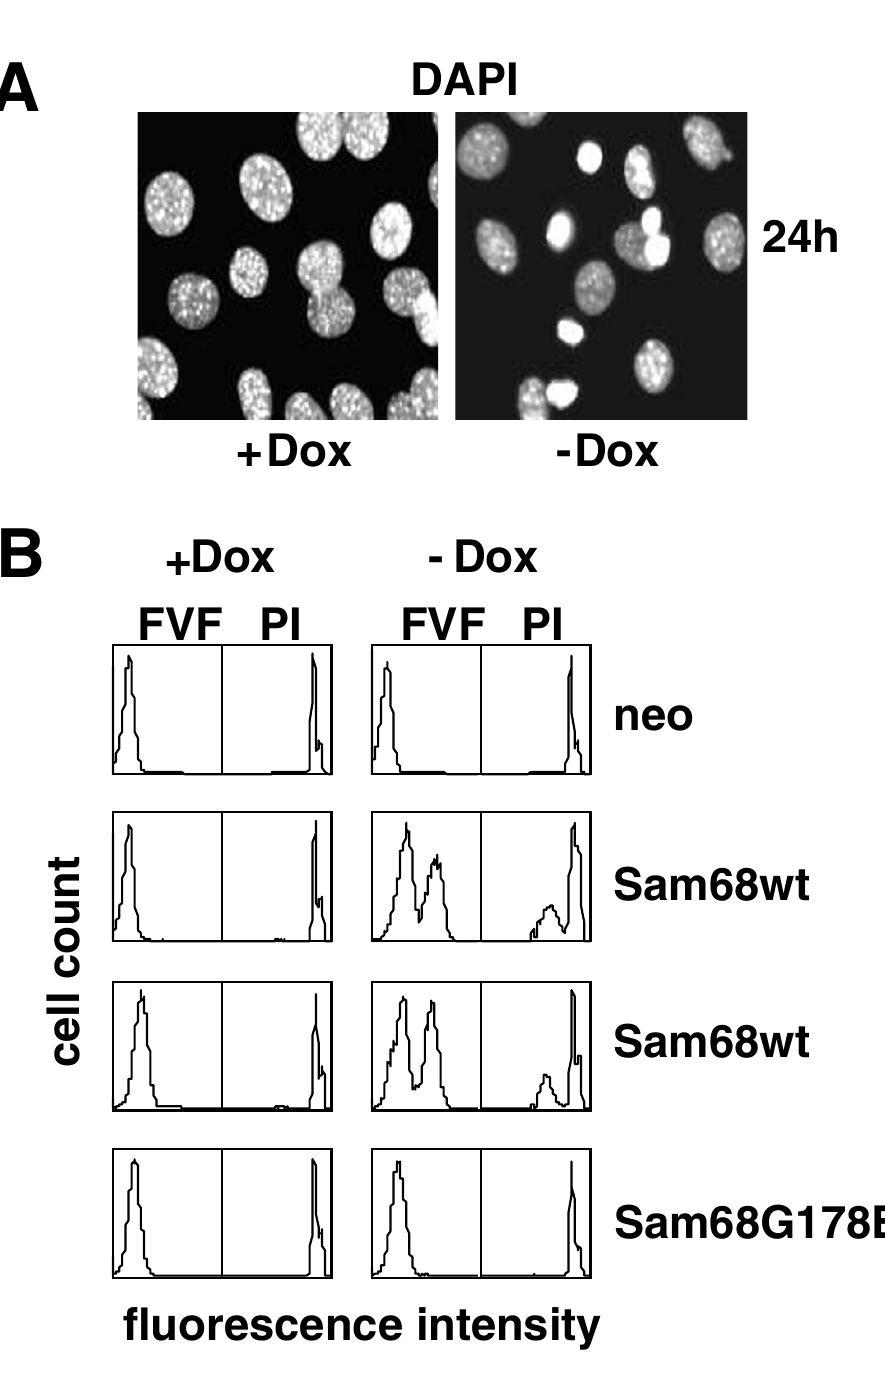
Figure 4 Sam68 overexpression induces apoptosis dependent on RNA binding. A. Tet -off cells conditionally expressing wild- type HA-Sam68 were cultured on coverslips in 10% serum with or without doxycycline for 24 h, fixed and stained with DAPI. B. Tet -off cell lines expressing the indicated Sam68 proteins were cultured in the presence or absence of doxycycline for 72 h and then assayed for caspase activation with a cell-permeable fluorescent caspase inhibitor, FAM-VAD-FMK (FVF). Fixed cells were counterstained prior to flow cytometry with propidium iodide (PI). Results with two different clones of cells expressing wt Sam68 are